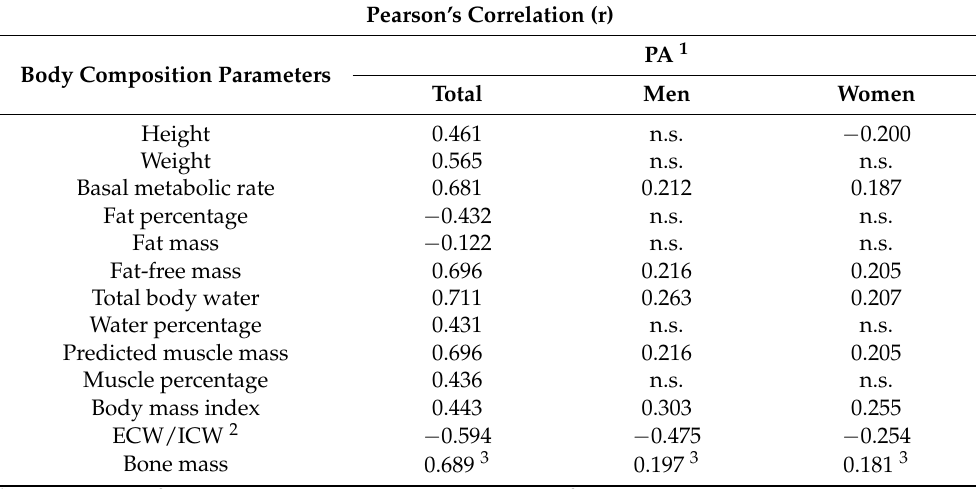
Table 4. Significant correlations ( p < 0.05) between PA and anthropometrics and body composition parameters.